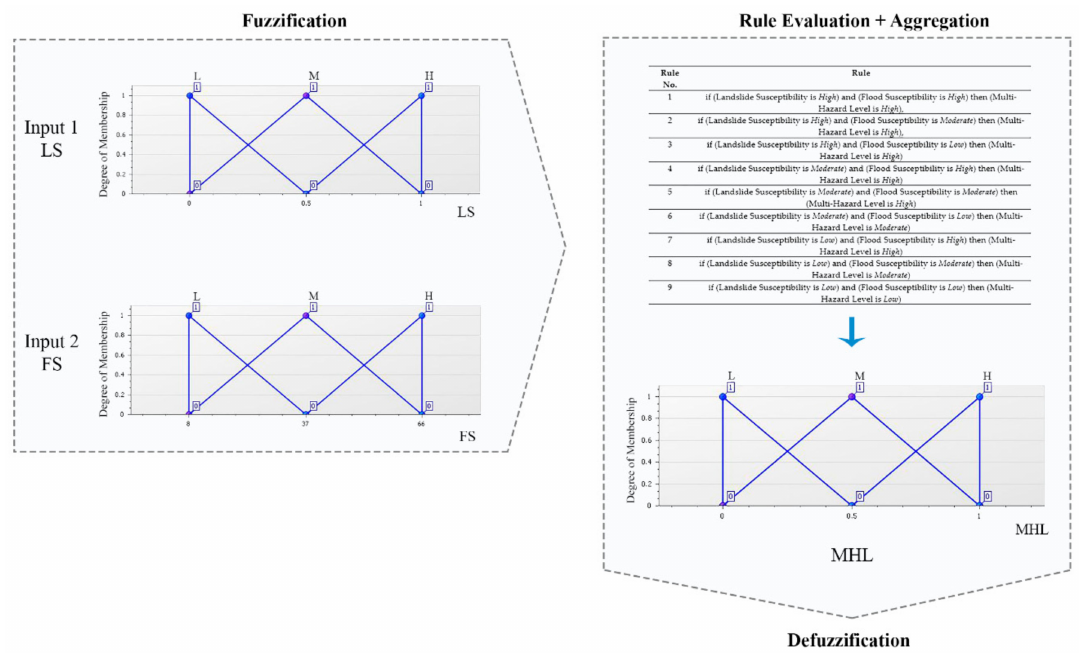
Figure 15. The general structure of the Mamdani fuzzy inference system (FIS)